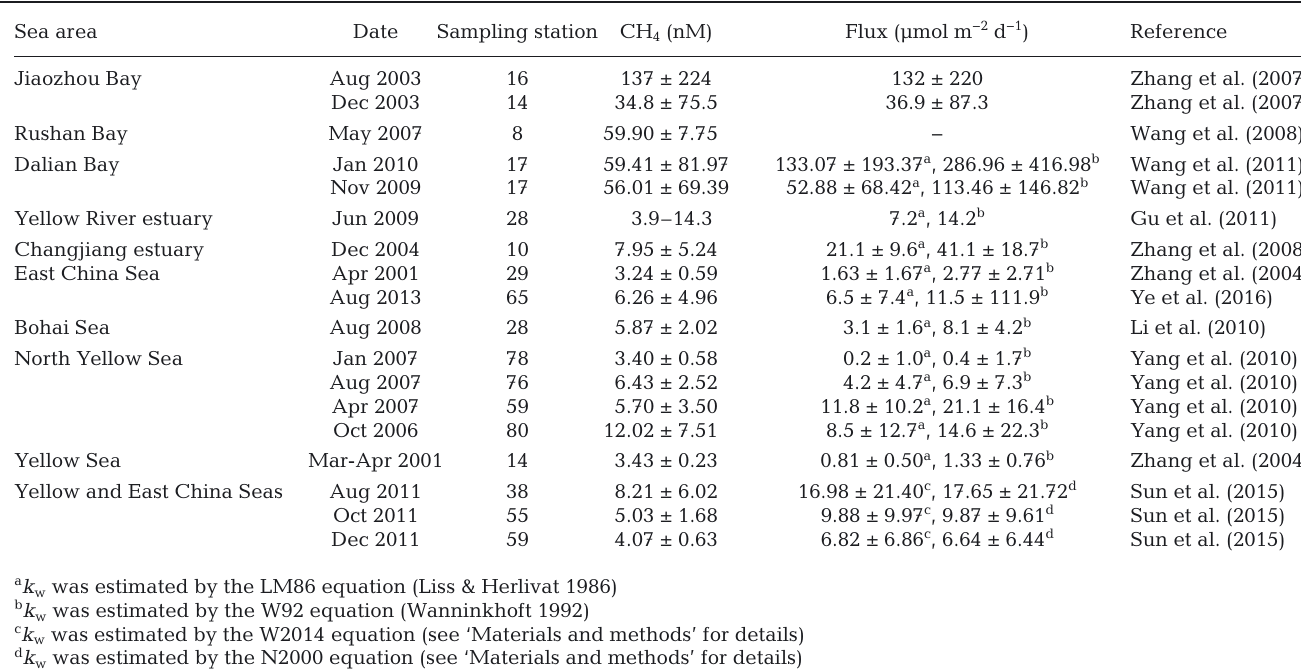
Table 2. Compilation of surface concentrations and sea-to-air fluxes of CH 4 in different coastal areas of China (see Fig. 2 for station locations). Data are mean ±